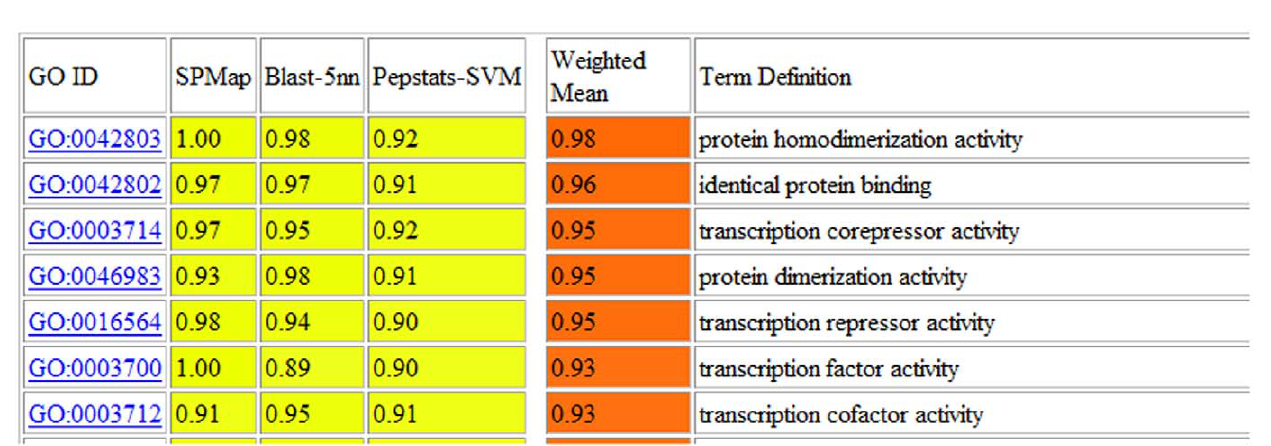
Figure 4. GOPred output for helt (HES/HEY-like transcription factor) protein.